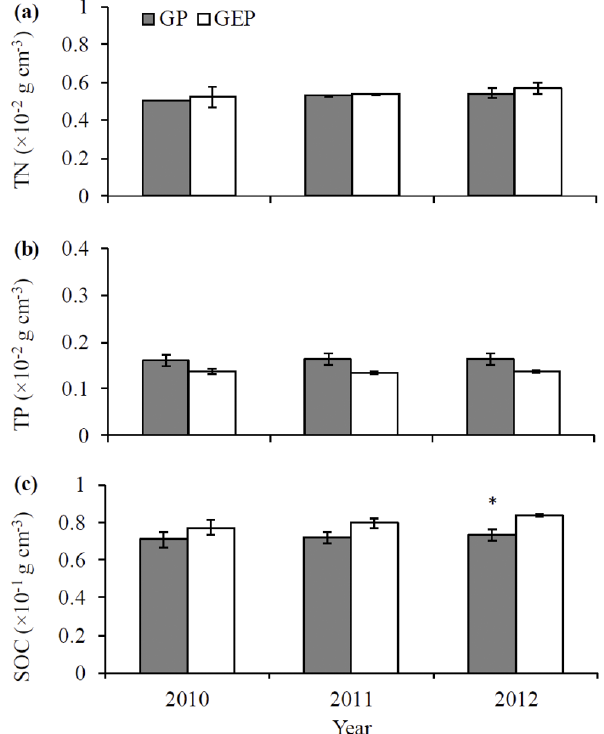
Figure 2. Mean ( ± SE) soil total nitrogen (TN) (a) , soil total phos- phorous (TP) (b) and soil organic carbon (SOC) (c) between the grazing paddocks (GP) and grazing exclusion paddocks (GEP). Sig- nificant difference was only found between GP and GEP for SOC in 2012 (LSD test: P < 0 .